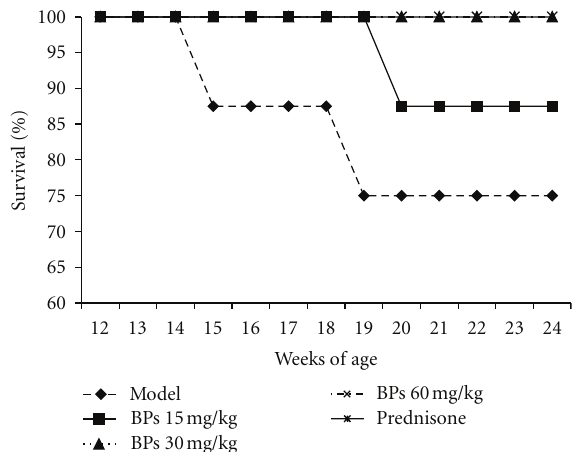
Figure 1: E ff ect of BPs on survival rate of MRL-lpr mice. MRL- lpr mice were grouped randomly and treated with BPs 15, 30, and 60mg · kg − 1 · day − 1 , prednisone 5 mg · kg − 1 · day − 1 , or model from week 12 to week 24 ( n = 8 per group); were data expressed as means ± SD.